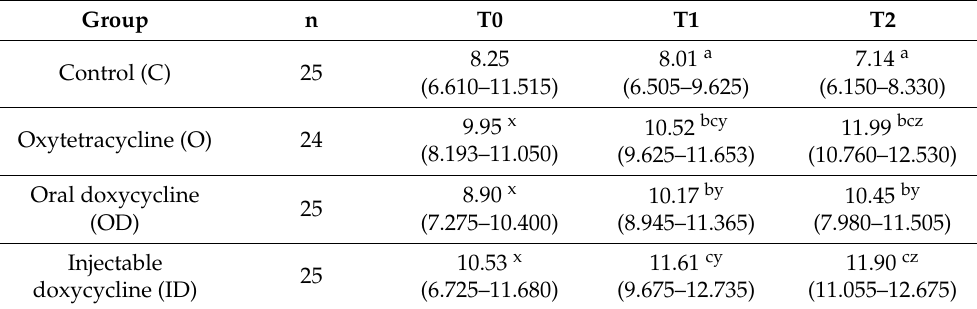
Table 2. Median (25th and 75th percentile values) erythrocyte levels (M/ µ L) of lambs that